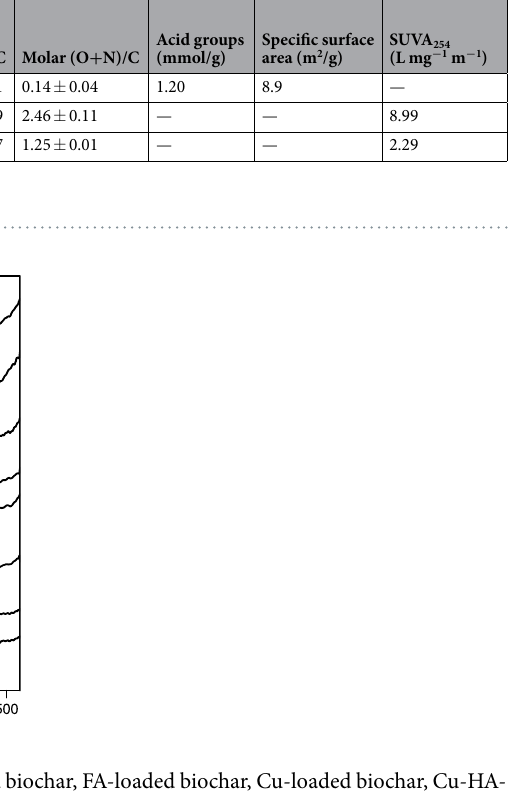
Figure 1. FTIR spectra of HA, FA, biochar, HA-loaded biochar, FA-loaded biochar, Cu-loaded biochar, Cu-HA- loaded biochar and Cu-FA-loaded